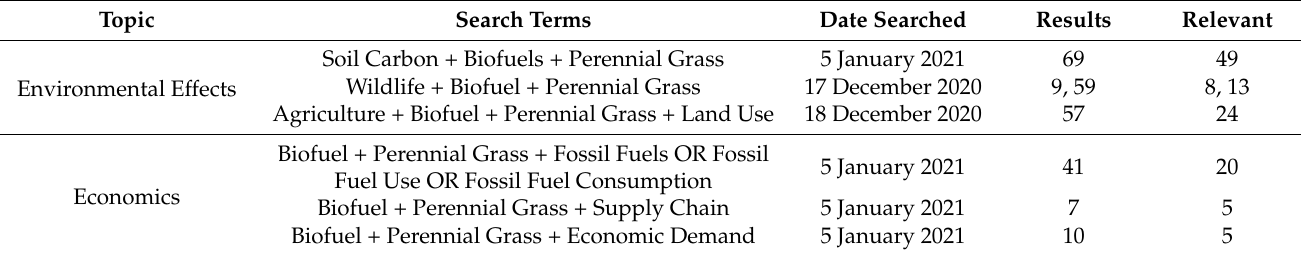
Table 1. Database search results for manuscripts by topic. Scopus is the primary database shown, if the secondary database Digitop was also used, the number of results is listed second.